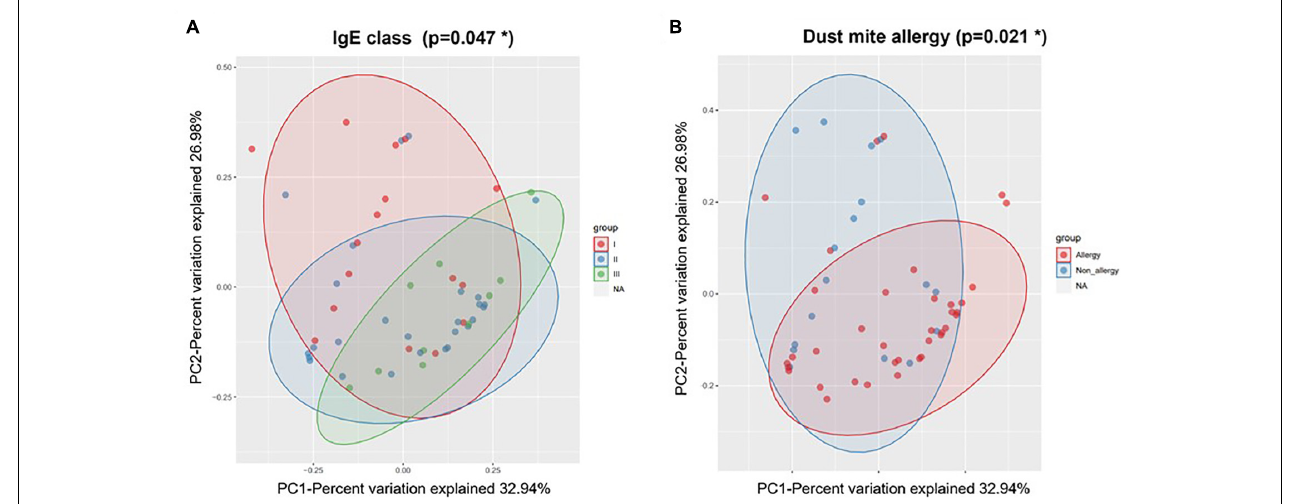
FIGURE 4 | Weighted beta diversity of nasal samples during AE grouped by (A) IgE class and (B) dust mite allergy. * p <